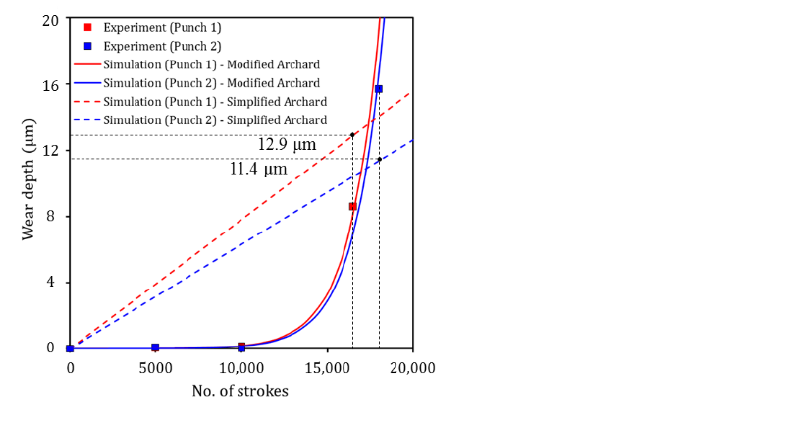
( b ) Figure 18. Contact pressure of the product formed with punch geometry without wear and worn punch geometry: ( a ) contour plot of contact pressure, ( b ) quantitative comparison of contact pres- sure.